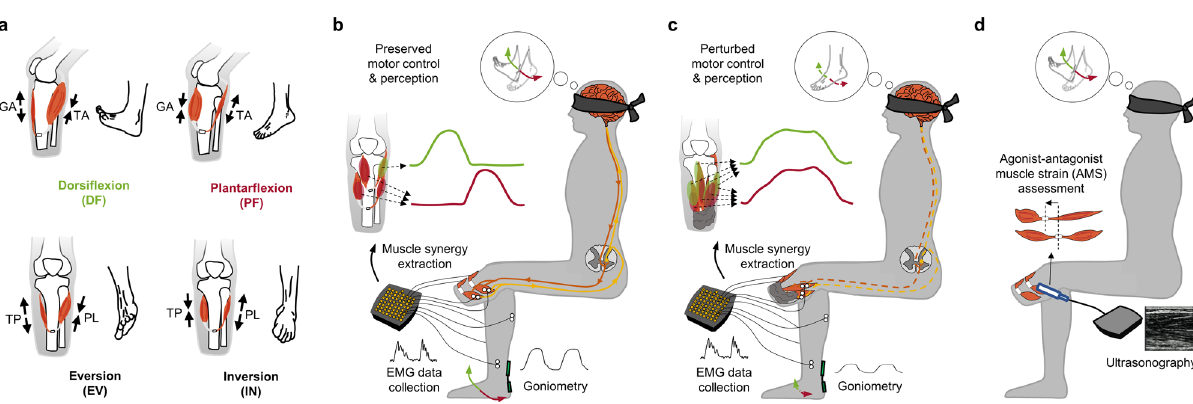
Fig. 1 Clinical evaluation of sensorimotor responses and the degree of agonist-antagonist muscle strain (AMS) for participant ’ s residual limb muscles. Shown in a , the Agonist-antagonist Myoneural Interface (AMI) amputation seeks to emulate physiological actuation of antagonistic muscle contraction and stretch. Ankle and subtalar AMI constructs are devised to create direct agonist-antagonist coupling for ankle dorsi and plantar fl exion and for subtalar eversion and inversion. For the ankle joint AMI construct, the tibialis anterior (TA) is linked to the lateral gastrocnemius (GA), and for the subtalar joint AMI construct, the tibialis posterior (TP) is linked to the peroneus longus (PL). In b and c , the experimental setup is shown. Motor control and phantom limb perception capacity are assessed in free space without visual or any other functional feedback. Perturbed motor control and perception are anticipated if a critical degree of AMS is not preserved in the limb. Representations of the dorsi and plantar fl exion synergic motor outputs are shown in green and red, respectively; efferent and afferent neural signals are shown in brown and yellow, respectively. Eversion and inversion were also tested but are not shown here. In d , AMS is computed from muscle fascicle changes during cyclic phantom ankle and subtalar joint movements. Here, the size and positioning of elements are representative and not to